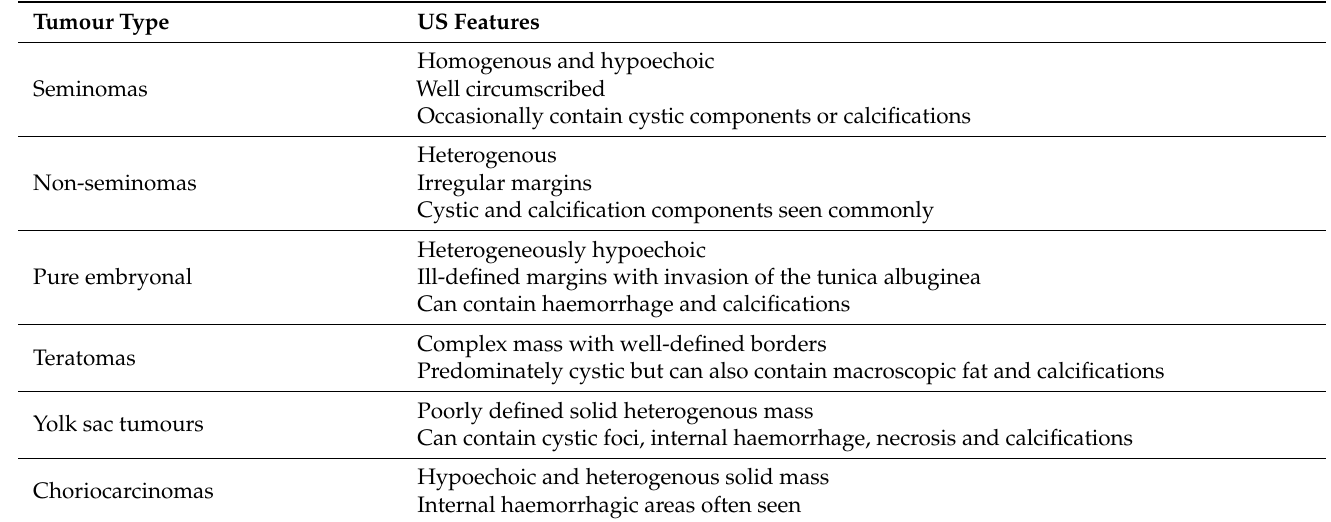
Table 1. Summarising ultrasound